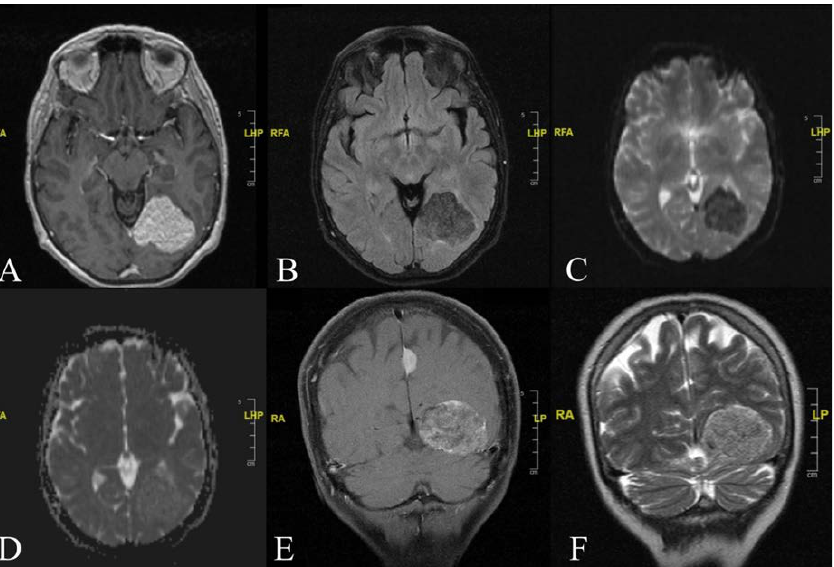
Figure 1. Preoperative Imaging. ( A ) Cranial T1-weighted MRI axial image with contrast showing the presence of extra-axial mass formation with of 44 × 38 mm with a craniocaudal extension of 38 mm that in the left parieto-occipital area exerts a modest compressive mass effects on the trigone and the occipital horn of the left lateral ventricle. ( B ) In the T2-weighted FLAIR sequence the lesion presents a low-intensity signal similar to fat tissue. Moderate presence of perilesional oedema indicating that the mass effect is not attributable to an oedematous process. ( C ) At Echo-Planar